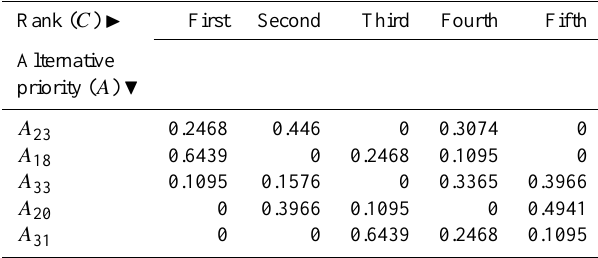
Table 14. The matrix of number time weight of ranking options.